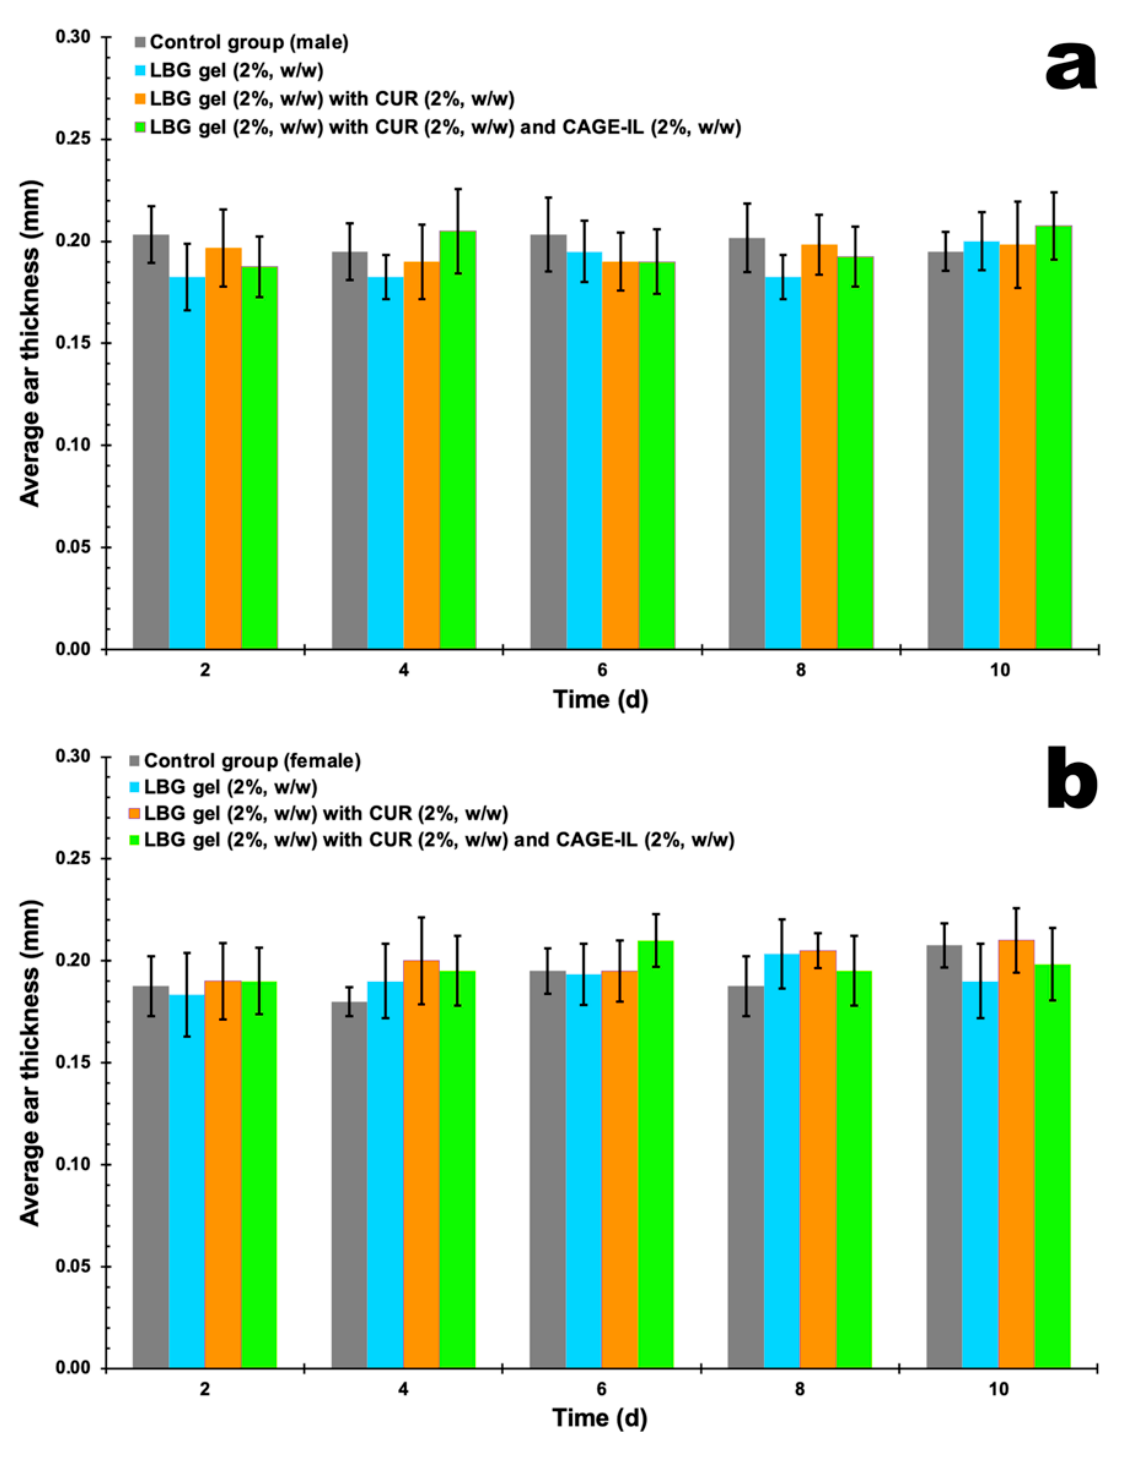
Figure 4. Results obtained for the evolution of the thickness of the ears of the animals in the control groups, during 20 d of application of LBG gel (2%, w/w ), LBG gel (2%, w/w ) with CUR (2%, w/w ) and LBG gel (2%, w/w ) with CUR (2%, w/w ) and CAGE-IL (2%, w/w ). ( a ) Male mice ( p > 0.05) and ( b ) female mice ( p > 0.05). The results displayed are the average of three determinations, and the error bars represent the standard deviations.